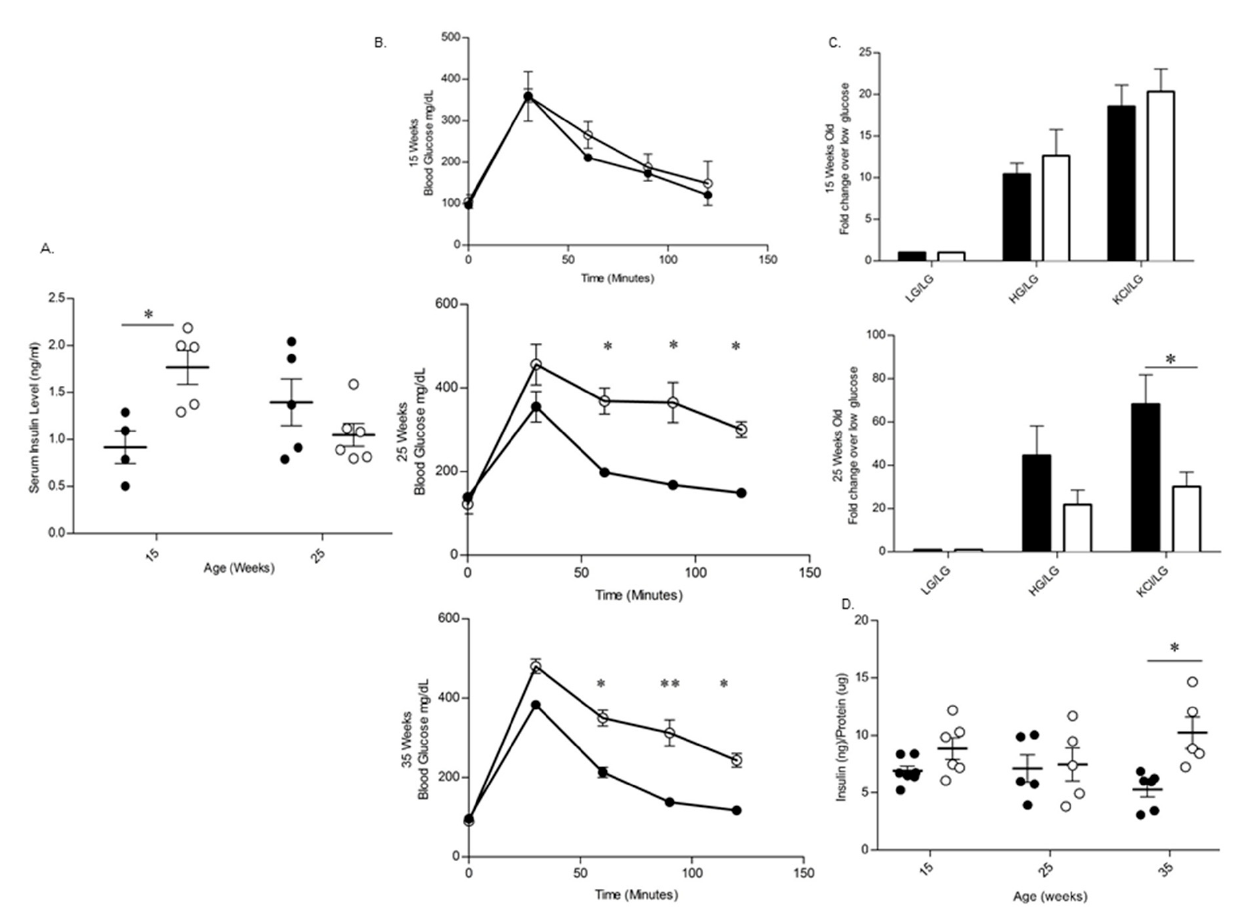
Figure 12. Metabolic study of BL/6 and BL/6-CD3FLAGmIR transgenic mice. ( A ) Non-fasting serum insulin levels of BL/6 (black circles) and BL/6-CD3FLAGmIR transgenic male mice (white circles). Each dot represents an individual mouse. One-way ANOVA followed by Tukey’s multiple comparison test, * p ≤ 0.05. ( B ) Intraperitoneal glucose tolerance test comparing BL/6 (black circles) and BL/6-CD3FLAGmIR transgenic male mice (white circles) at 15, 25, and 35 weeks of age (n = 4 mice per group). Unpaired student t test, * p ≤ 0.05, ** p ≤ 0.01. ( C ) Glucose stimulated insulin secretion in vitro at age 15 ( n = 4) and 25 weeks ( n = 5) in BL/6 (Black bars) and BL/6-CD3FLAGmIR (White bars). Welch’s t test, * p ≤ 0.05. ( D ) Total Insulin Content of pancreas from BL/6 (black circles) and BL/6-CD3FLAGmIR transgenic male mice (white circles) at 15, 25, and 35 weeks of age. Each dot represents an individual mouse, Two-way ANOVA followed by Tukey’s multiple comparison test, * p ≤ 0.05.